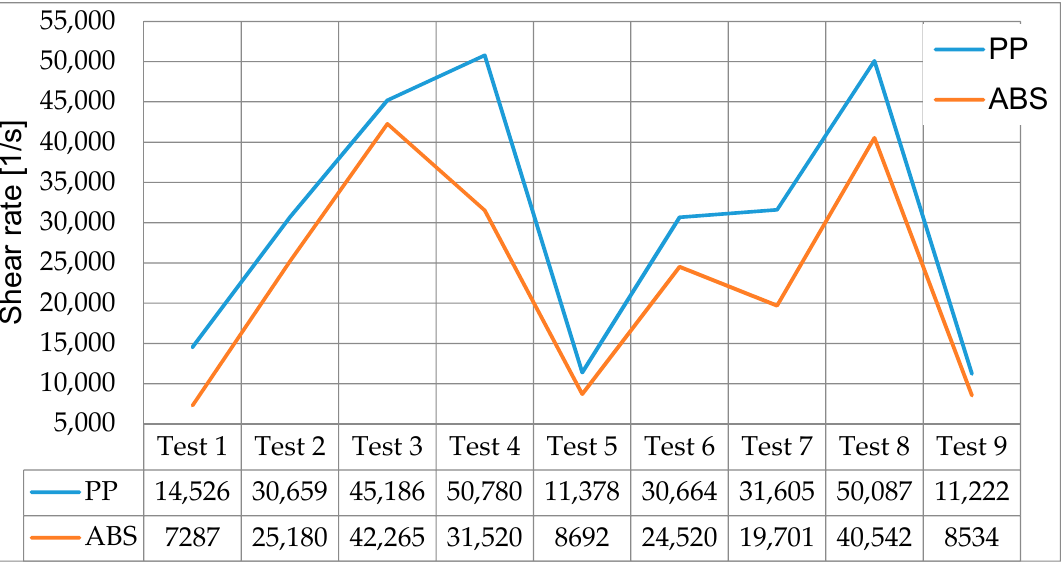
Figure 4. Comparison between T i and T ff on filling for PP and Acrylonitrile butadiene styrene (ABS).